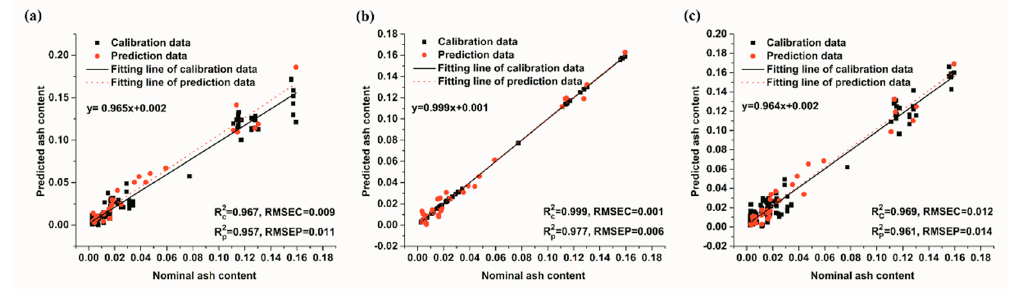
Figure 4. Model fitting results for Ash. ( a ) PLSR (partial least-squares regression); ( b ) LS-SVM (the least-squares support vector machine); ( c ) ELM (extreme learning machine).